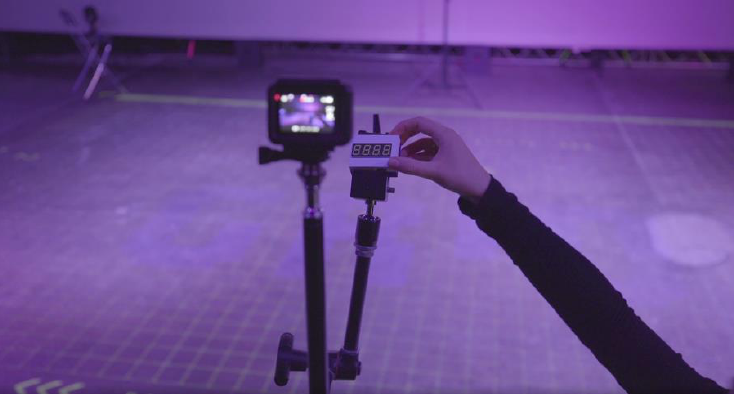
Figure 4. The electrodermal activity (EDA) device. The electrodes on the hand are connected to sensor cables which are connected to the portable EDA device. A black armband is on the arm to secure the sensor cable.